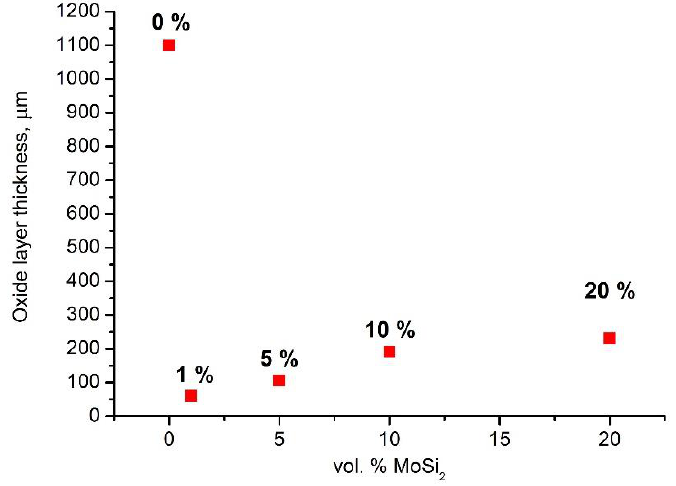
Figure 10. Thickness of the oxide film on the Hf(C,N) surface as a function of MoSi 2